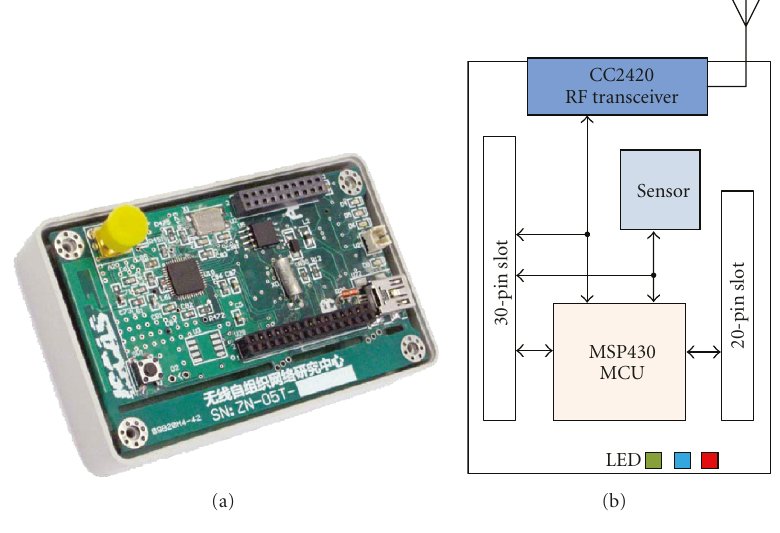
Figure 10: ZiNT sensor node.